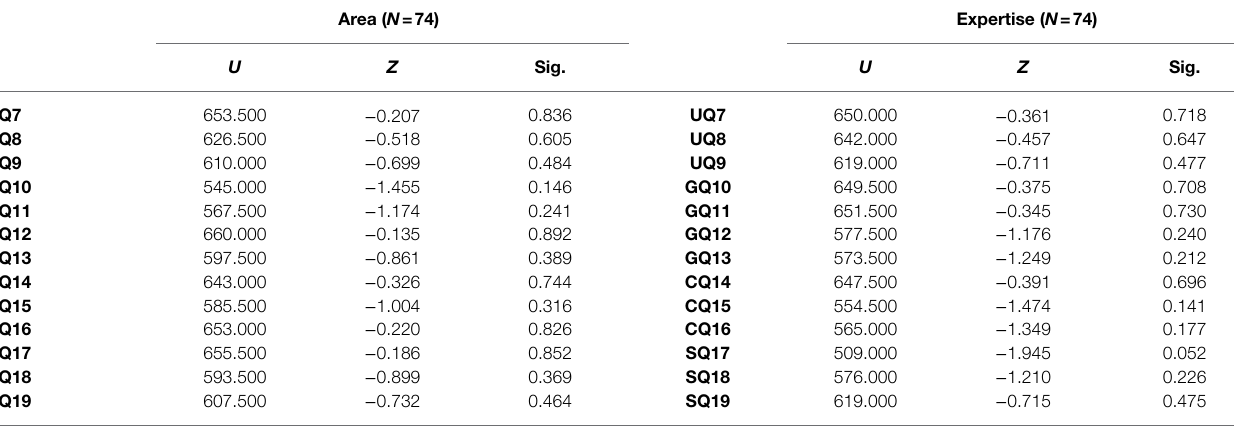
TABLE 3 | Mann–Whitney U results for variables area and expertise (less than 5 years teaching vs. more than 5 years teaching).